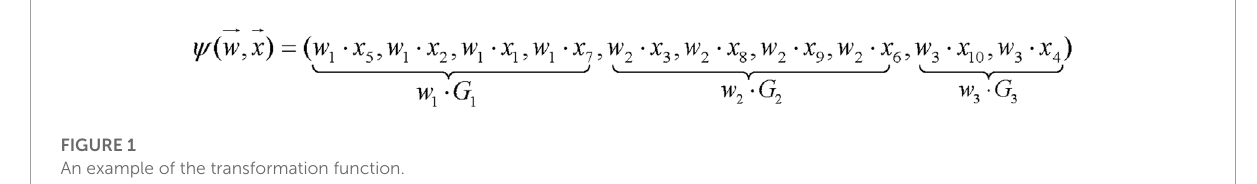
FIGURE 1 An example of the transformation